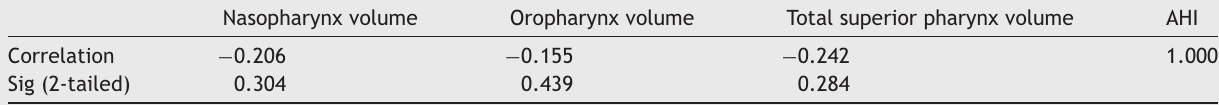
Table 6 Spearman’s rank correlation coefficient between volume and AHI, controlling by BMI, age and gender. Nasopharynx volume Oropharynx